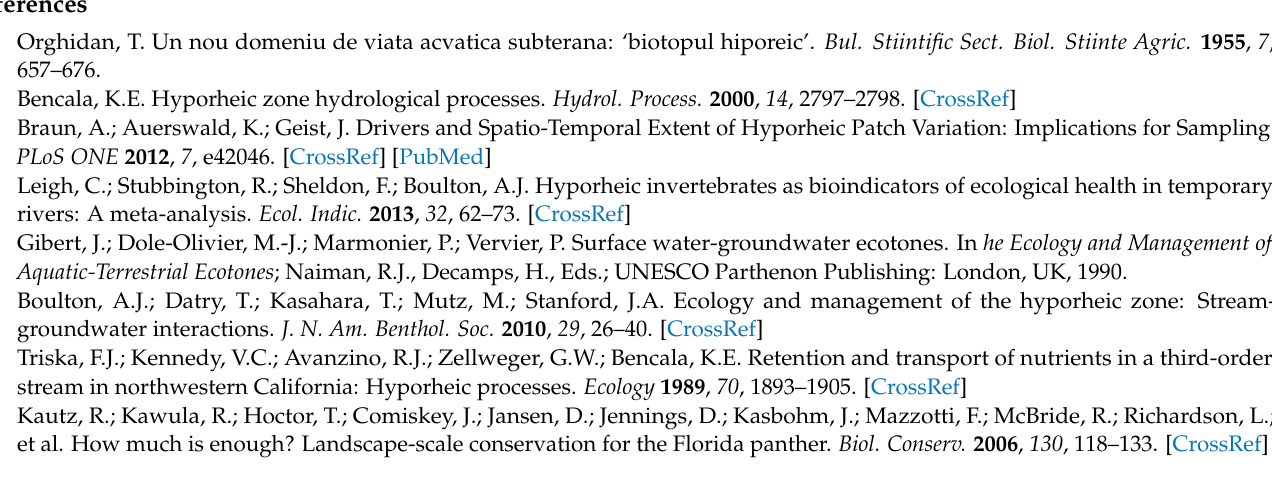
Figure S1: Non metric multidimensional scaling (nMDS) plot of samples from the two investigated sub-basins (HEN—Heras de Ayuso, Henares River; and TAJ—Romanones, Tajuna River) based on copepod